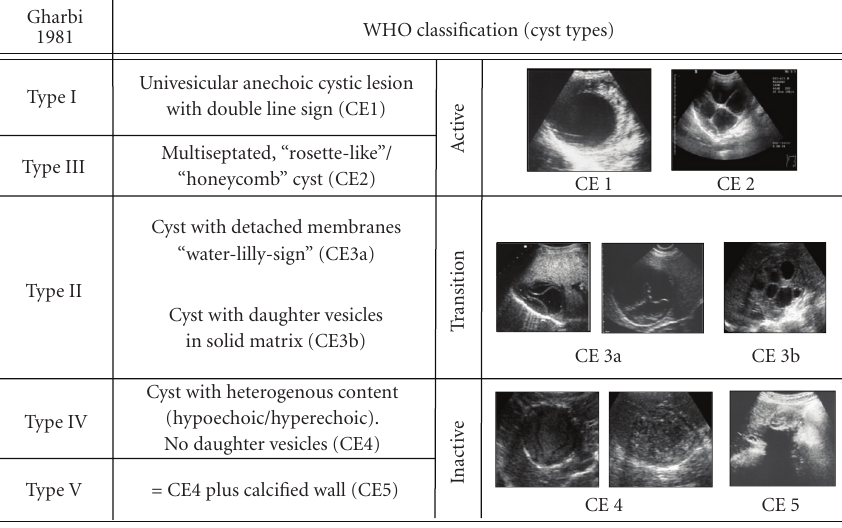
Figure 3: WHO US classification of hydatid